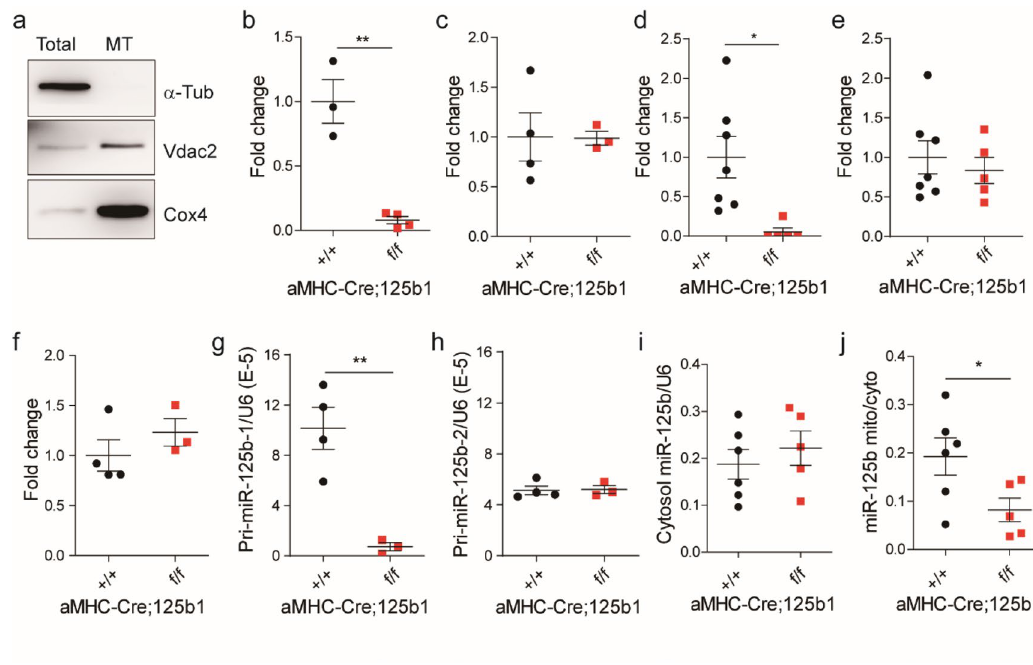
Figure 4. Mitochondrial miRNA-125b expression in neonatal and adult hearts. ( a ) Confirmation of isolated mitochondria from neonatal hearts. Vdac2 and Cox4 are mitochondrial proteins and αtubulin is a cytosolic protein. MT: mitochondria. Vdac2, Cox2 and αtubulin were cropped from the same blot. The original images of blot were showed in Fig. S7. ( b ) Mitochondrial miRNA-125b expression in neonatal hearts. A spike-in control, cel-mir-39, was used to normalize the technical error (n = 3 vs. 4, p = 0.0015). ( c ) MiRNA-125b expression in young adult myocardium (n = 4 vs. 3, p = 0.9667). ( d ) Pri-miR-125b-1expression in young adult myocardium (n = 7 vs. 5, p = 0.0139). ( e ) Pri-miR-125b-1expression in young adult myocardium (n = 7 vs. 5, p = 0.5758). ( f ) Pri-miR-125b-1 expression in isolated cardiomyocytes from young adult myocardium (n = 4 vs. 3, p = 0.0053). ( h ) Pri-miR-125b-2 expression in isolated cardiomyocytes from young adult myocardium (n = 4 vs. 3, p = 0.8961). ( i ) Cytosolic miR-125b expression in young adult hearts (n = 6 vs. 5, p = 0.1874). ( j ) The ratio of mitochondrial miR-125b to cytosolic miR-125b in young adult hearts (n = 6 vs. 5, p = 0.0470). The significance of the differences between control and knockout groups were determined by unpaired Student t